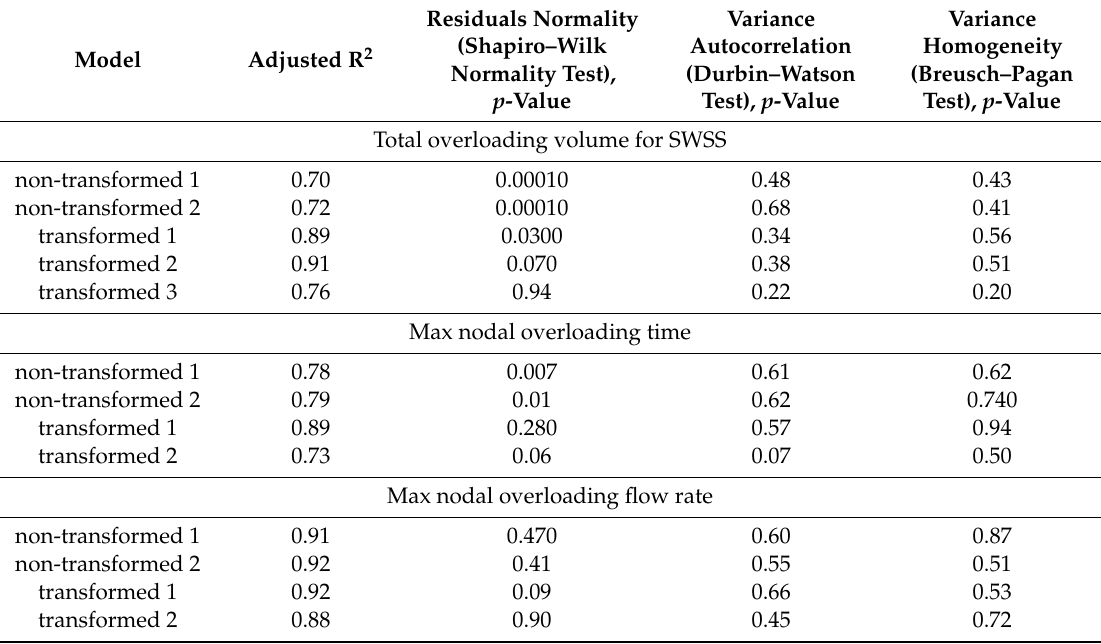
Table A3. Results of MLR fitting and assumptions